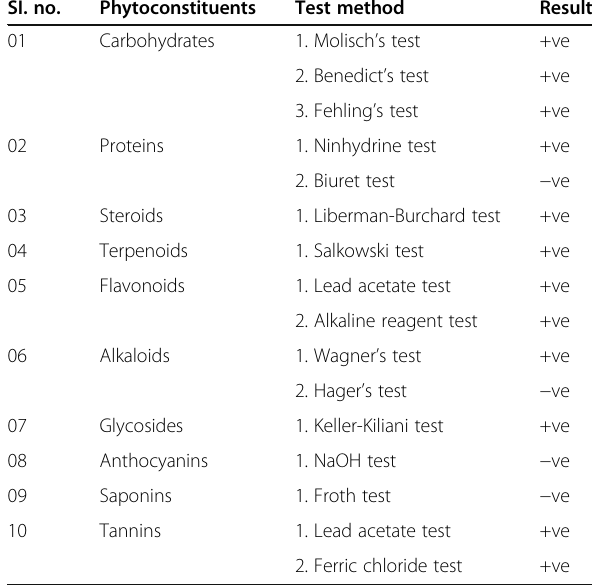
Table 1 Phytochemical screening of ethanolic extract of Psidium guajava Linn leaves SI.